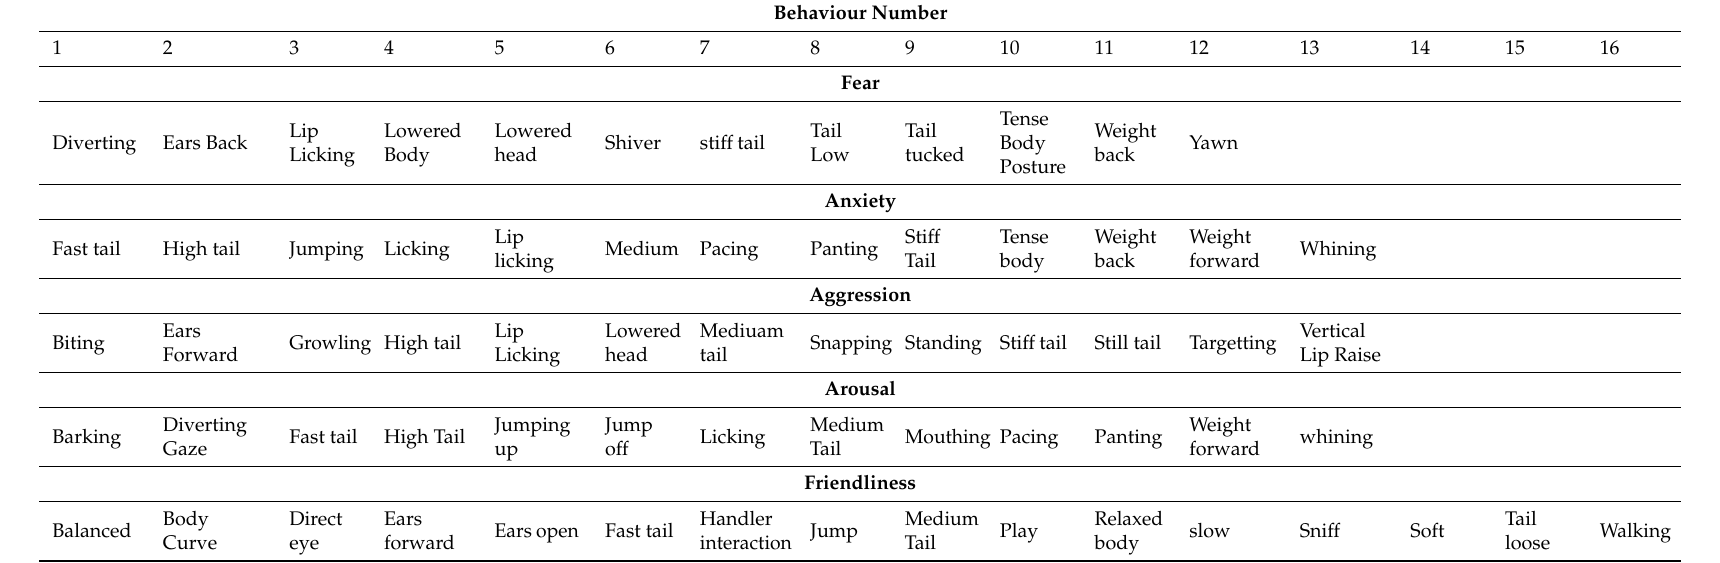
Table 3. The behaviours contributing to the emotional states Fear, Anxiety, Aggression, Arousal, and